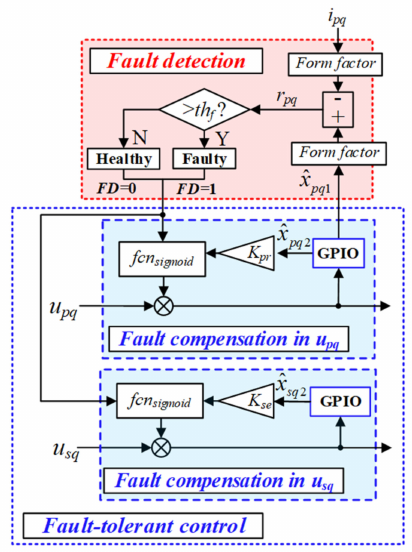
Figure 8. Block diagram of AFTC strategy in q -axis of a five-phase PMSG